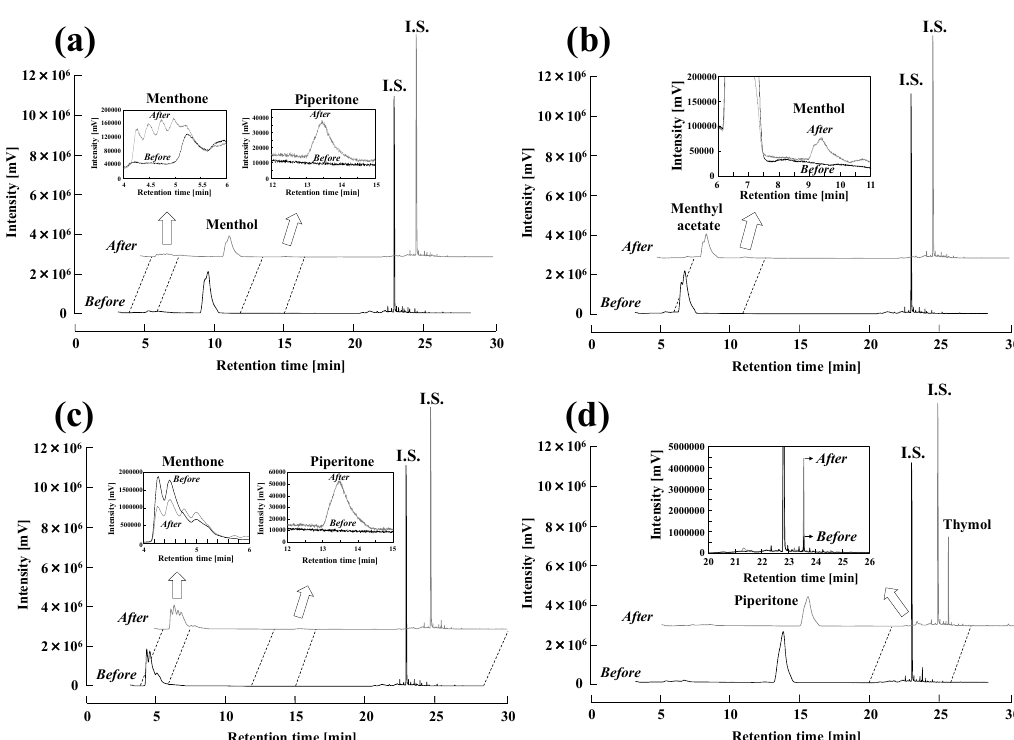
Figure 2. Individual treatments of the mint flavor components including ( a ) l -menthol, ( b ) l -menthyl acetate, ( c ) l -menthone, and ( d ) piperitone. Each of the subcritical water treatments was carried out at 240 °C for 60 min. Before the analysis of GC-MS, phenol (internal standard) was mixed with the treated sample and the final concentration of phenol was 1% ( w/v ).